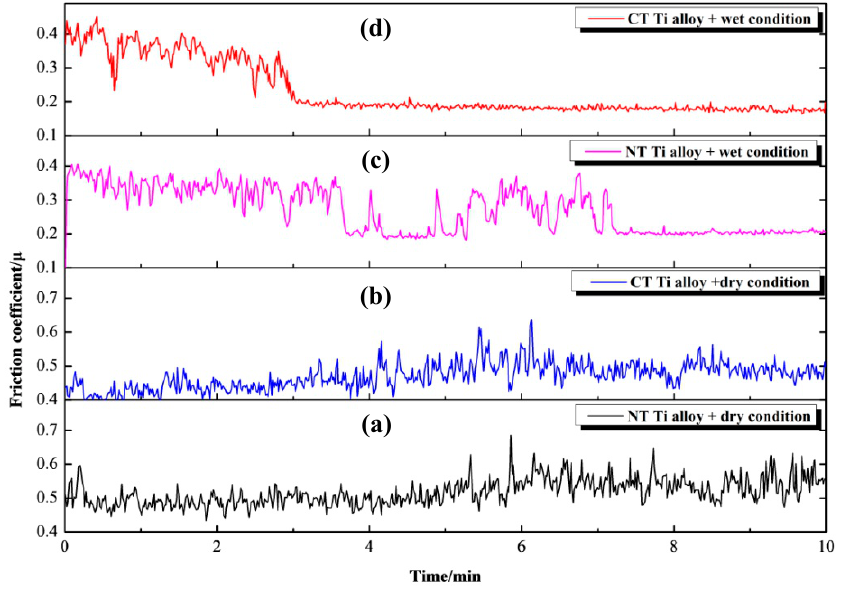
Figure 4. The friction coefficients of Ti-6Al-4V alloy with and without cryogenic treatment: ( a ) the friction coefficients of NT Ti alloy under dry conditions; ( b ) the friction coefficients of CT Ti alloy under dry conditions; ( c ) the friction coefficients of NT Ti alloy under wet conditions; and ( d ) the friction coefficients of CT Ti alloy under wet conditions.